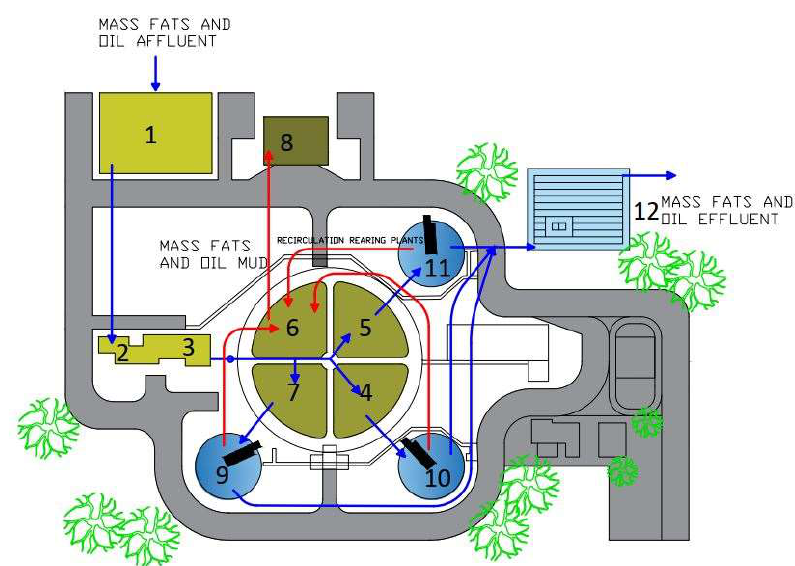
Figure 2. The wastewater treatment plant (WWTP) in this study. 1: Wastewater elevating plant. 2: Sedimentation tank. 3: Skimmer / degreaser. 4,5,7: Reactors. 6: Aerobic digester. 8: Band filter.